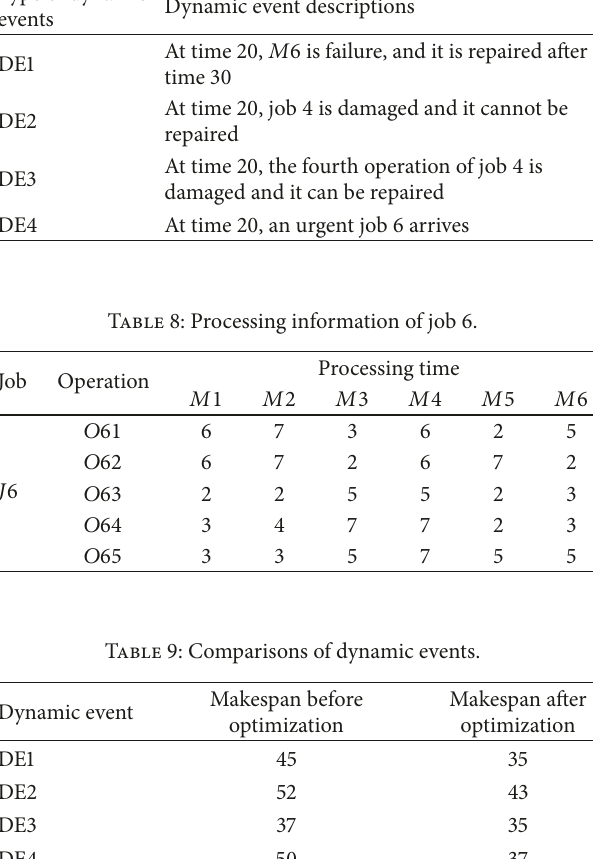
Figure16:ReschedulingGanttchartbyusingdynamicrescheduling strategy.